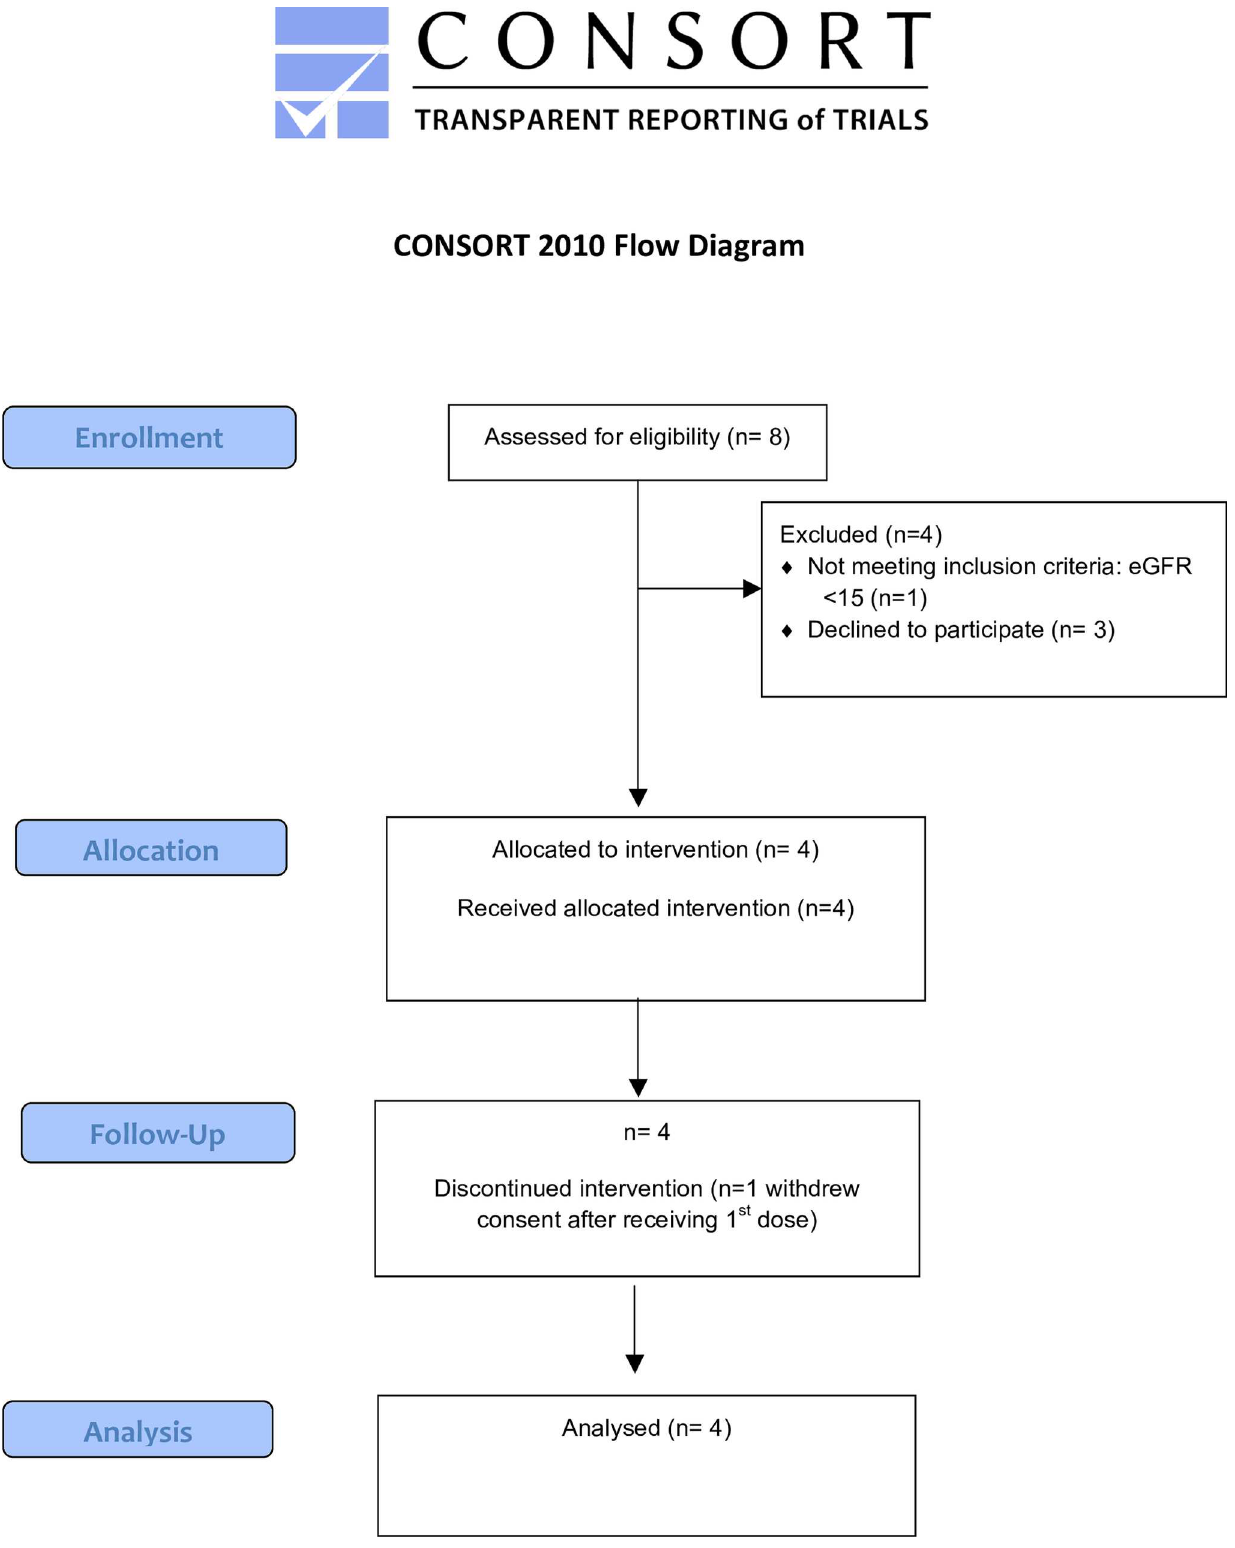
Fig 1. CONSORT Flow Diagram. Consortdiagram of patientseligible, recruited, numbers followed up and included in analysis.